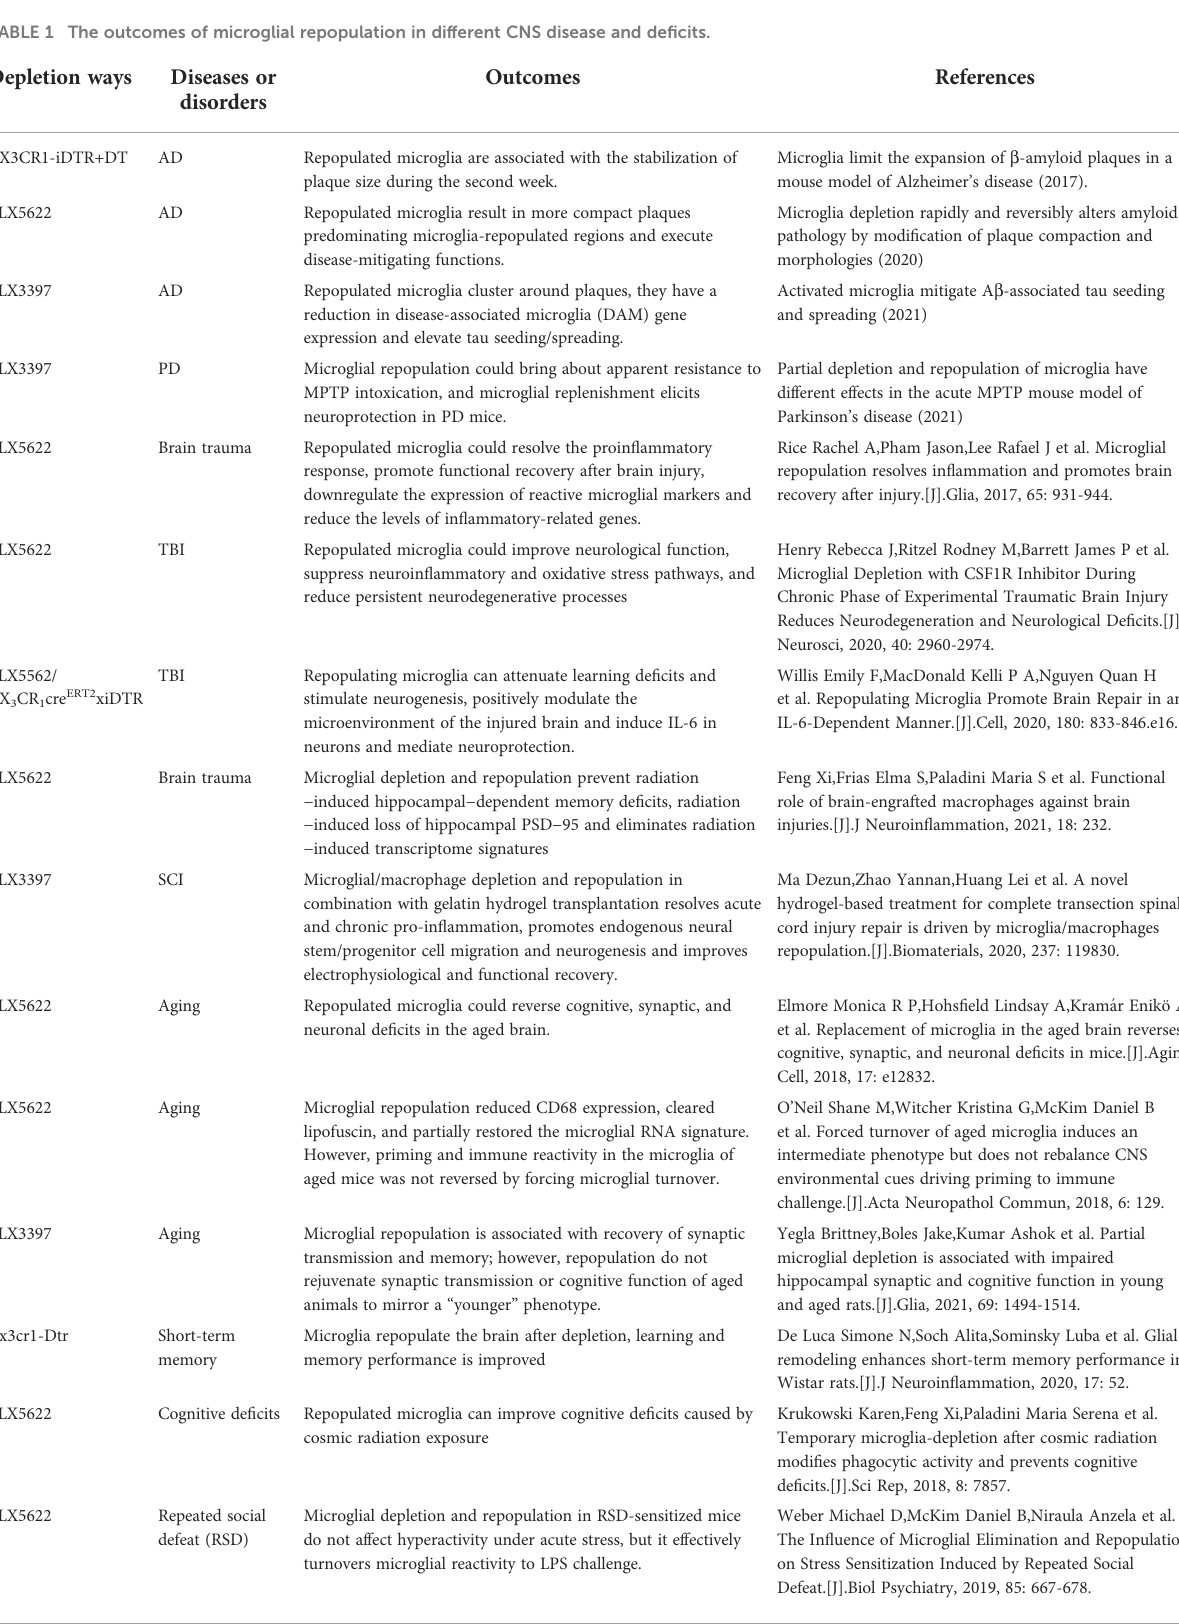
TABLE 1 The outcomes of microglial repopulation in different CNS disease and de fi